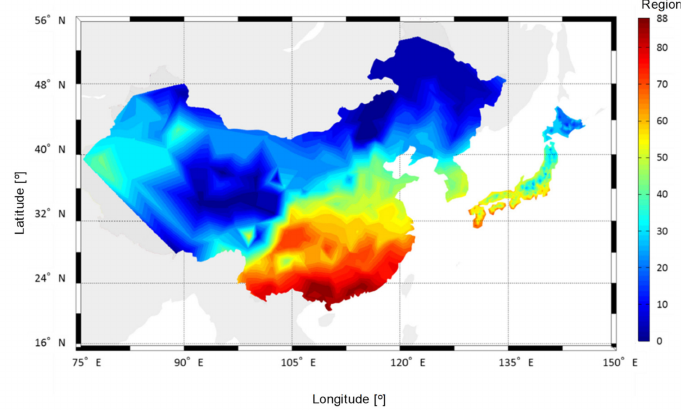
Figure 10. Climate classification for solar thermal energy in East Asia (88 areas) (based on Table